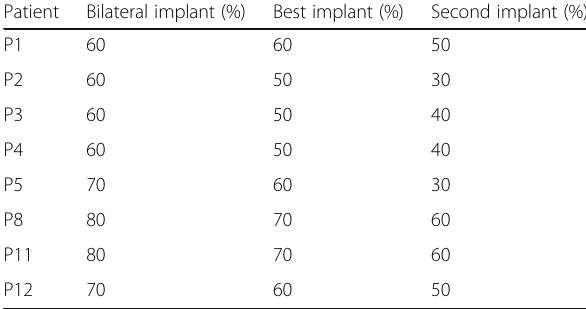
Table 4 HCST for the post-lingual group, comparison of HCST with the bilateral and unilateral implant for post-lingual after 1 year of the second implantation Patient